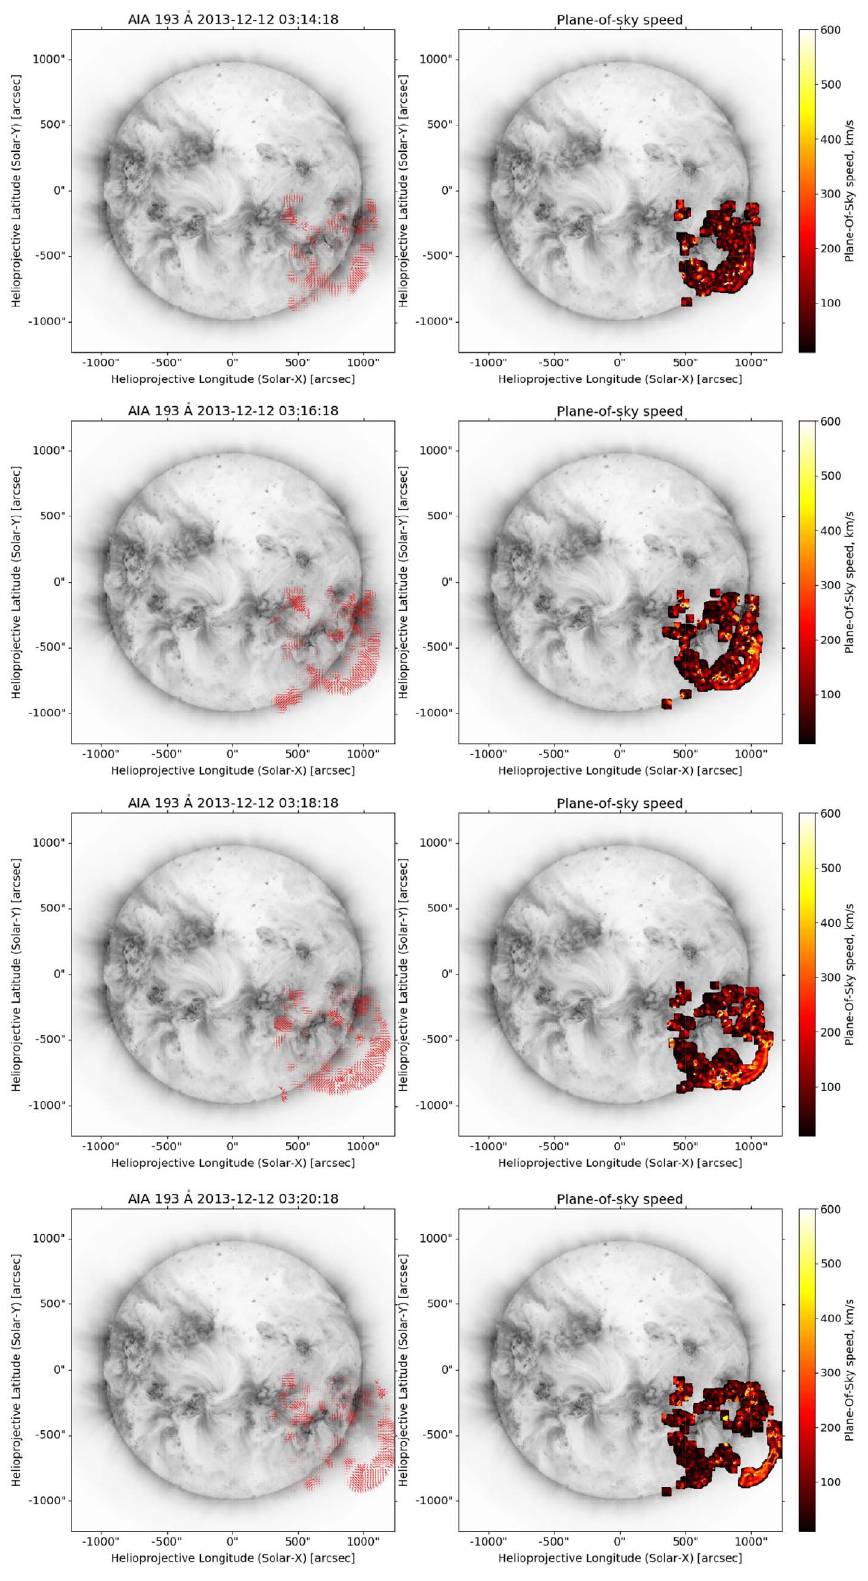
Fig. 12. The output of the FLCT model for the December 12, 2013 event, for the four pairs of consecutive images is shown in Figure 11. Left panels: Arrows showing the plane-of-sky velocity. Right panels: The plane-of-sky